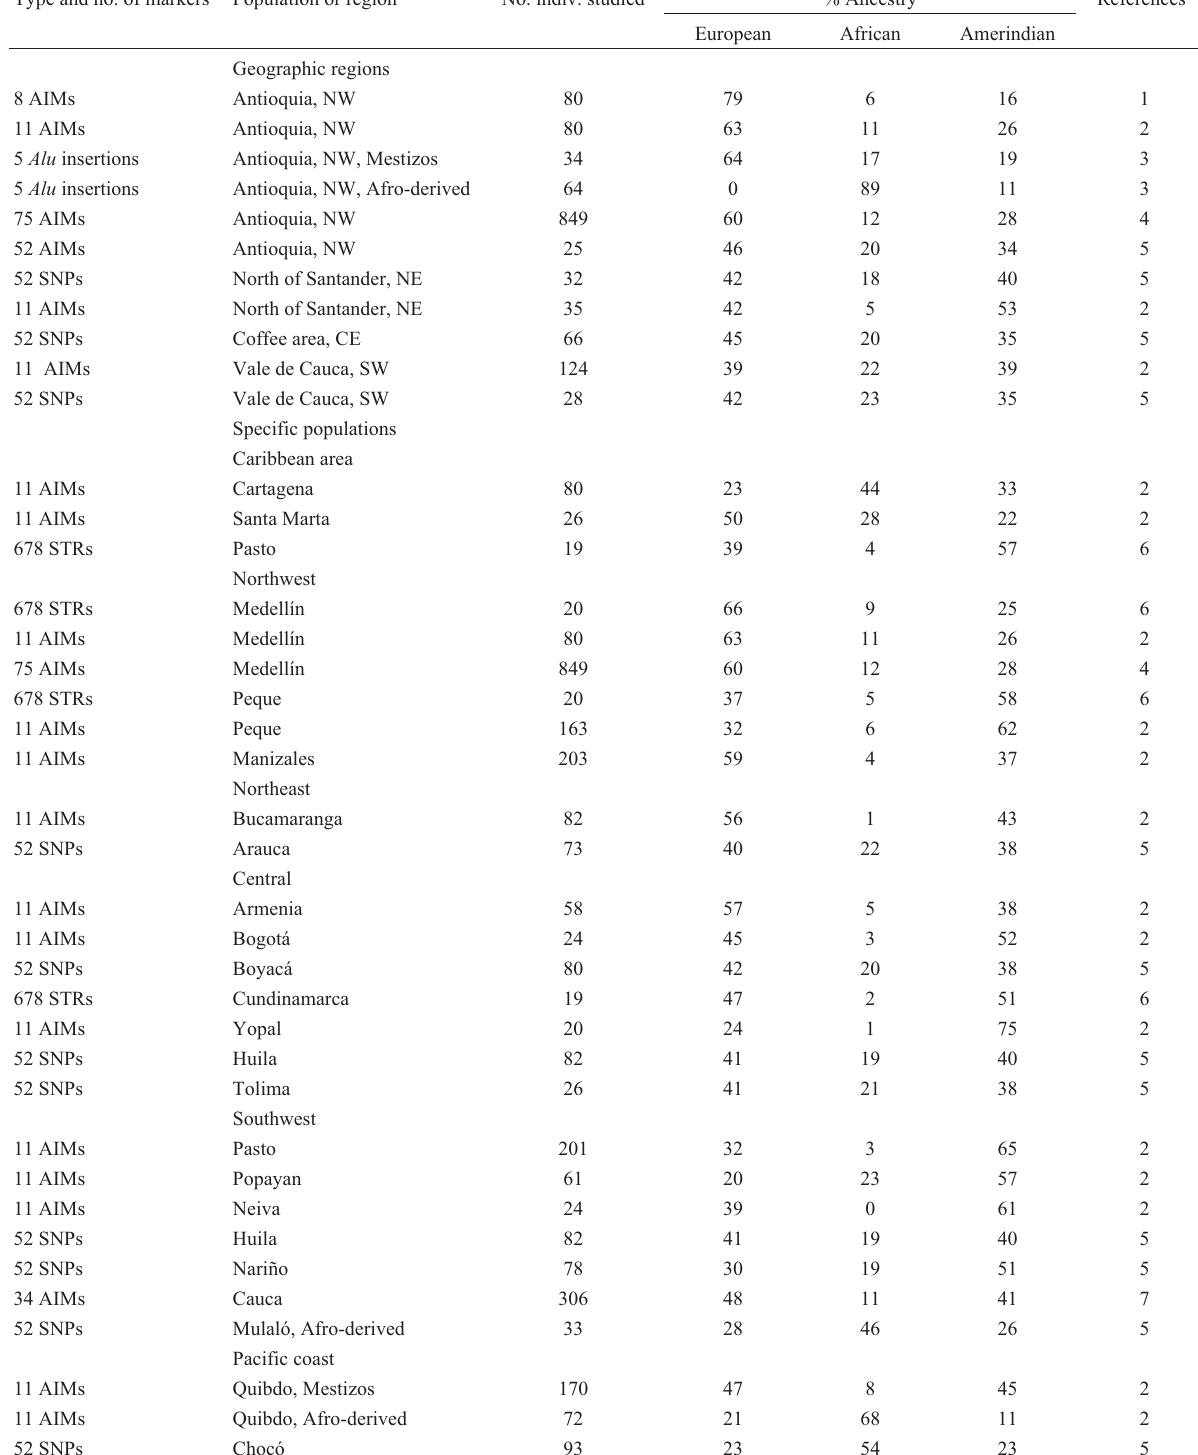
Table 3 - Molecular autosome estimates of parental continental ancestry in different segments of the Colombian populations 1 . Type and no. of markers Population or region